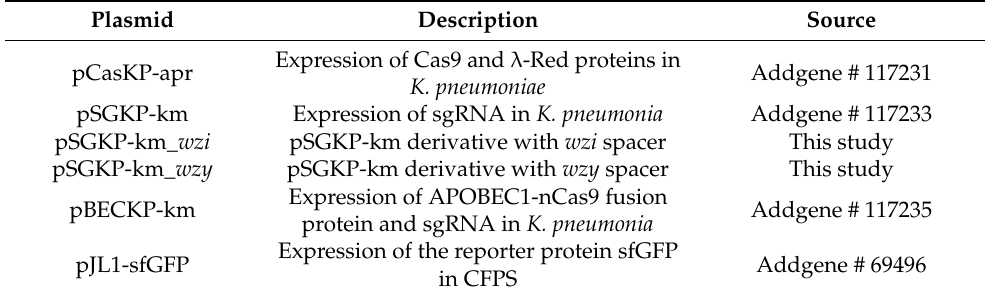
Table 1. Plasmids used in this study. Plasmid Description Source Expression of Cas9 and λ -Red proteins in pCasKP-apr Addgene # 117231 K. pneumoniae pSGKP-km Expression of sgRNA in K. pneumonia Addgene # 117233 pSGKP-km_ wzi pSGKP-km derivative with wzi spacer This study pSGKP-km_ wzy pSGKP-km derivative with wzy spacer This study Expression of APOBEC1-nCas9 fusion Addgene # 117235 pBECKP-km protein and sgRNA in K. pneumonia Expression of the reporter protein sfGFP Addgene # pJL1-sfGFP in CFPS